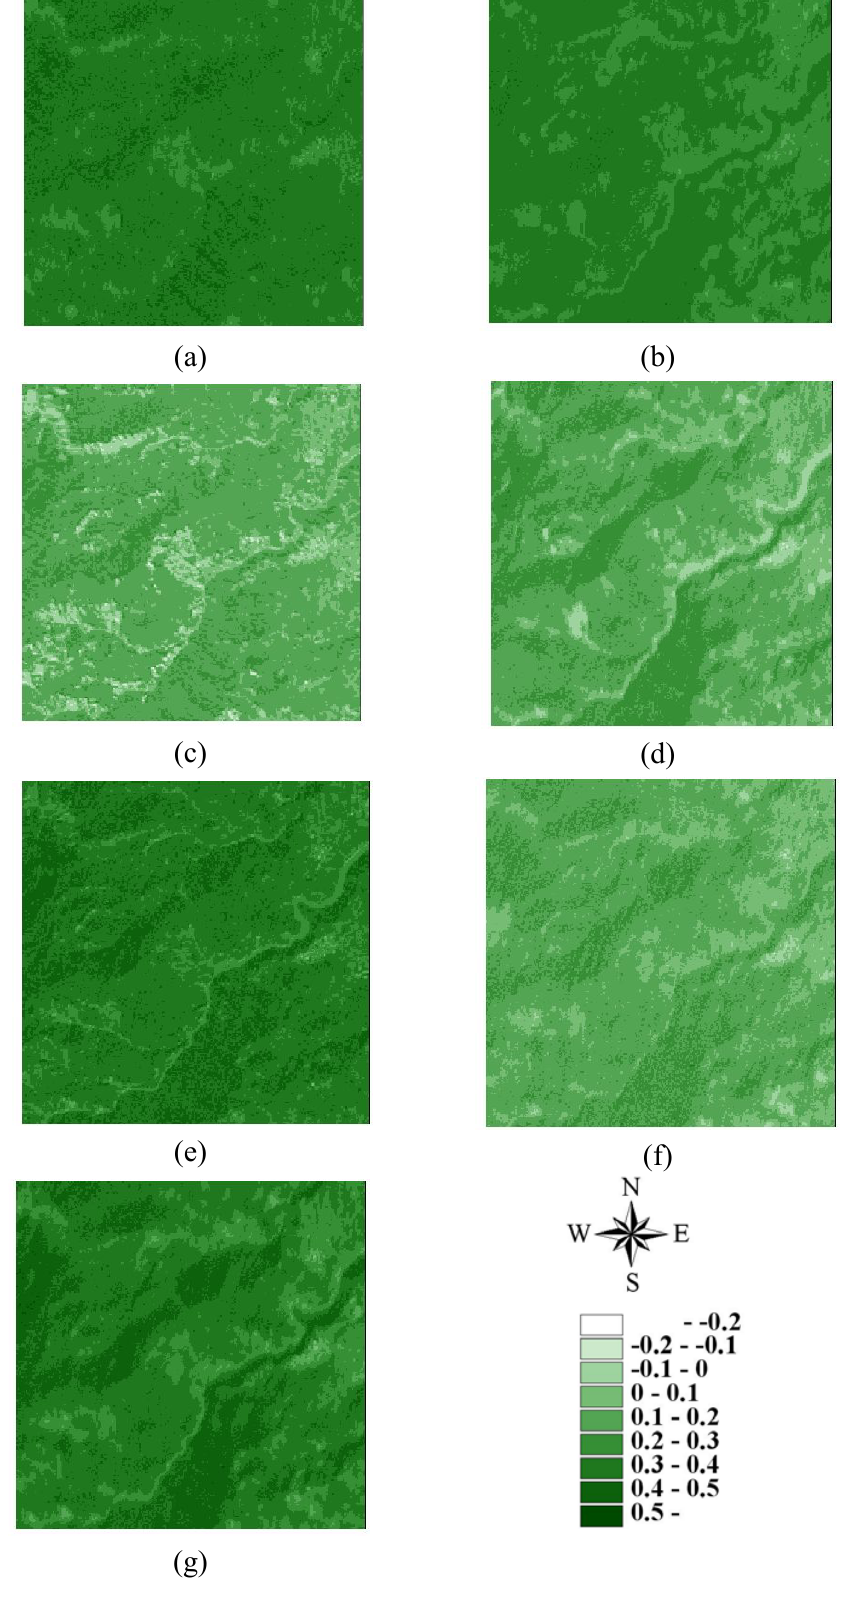
Figure 3. NDVI images of area B on (a) 1996/11/08, (b) 1999/03/06, (c) 1999/10/31, (d) 2000/11/27, (e) 2001/11/20, (f) 2003/12/17, and (g)